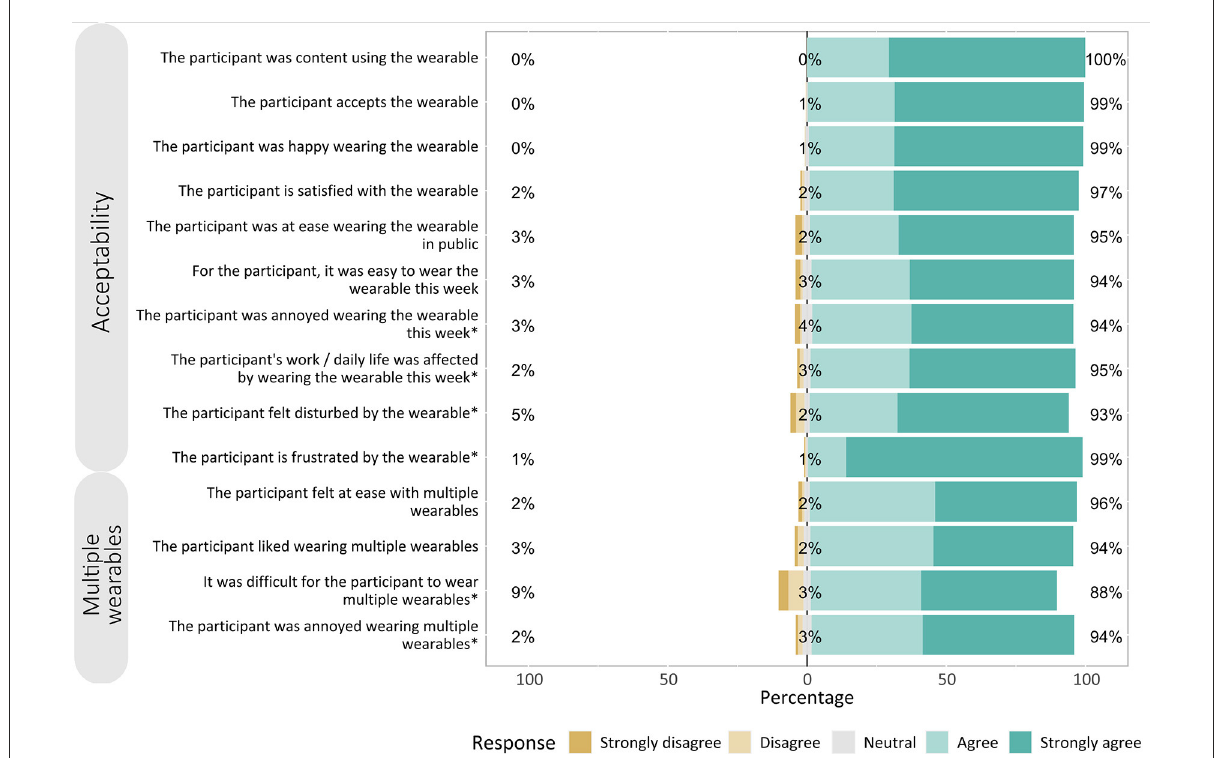
FIGURE3 Responses to Likert-type questions. Likert-type responses and their percentages according to the three categories: (1) acceptability of wearing a wearable, (2) wearing multiple wearables at once, and (3) technical feasibility of implementation and maintenance. Items with negative statements (marked with *) have reversed scales for readability and